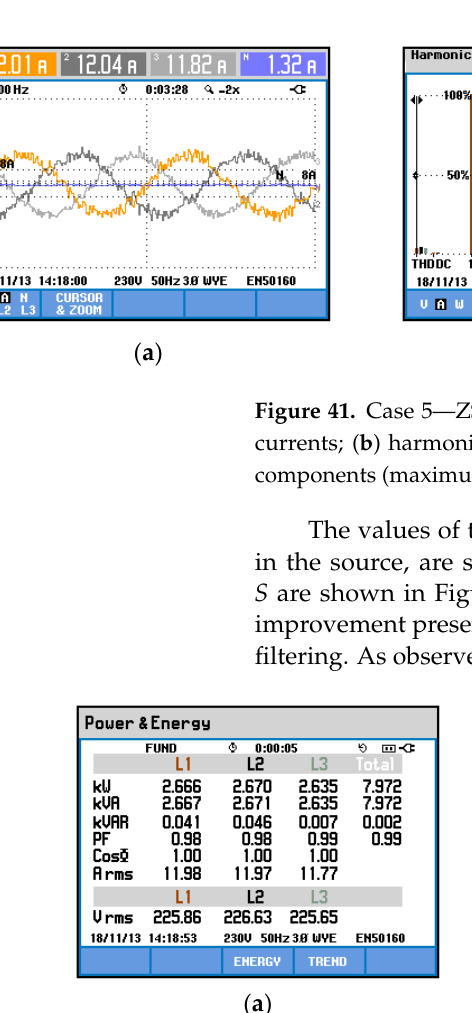
Figure 40. Case 5 - ZSS and three-wire ShAPF operating with unbalanced loads: ( a ) three-phase